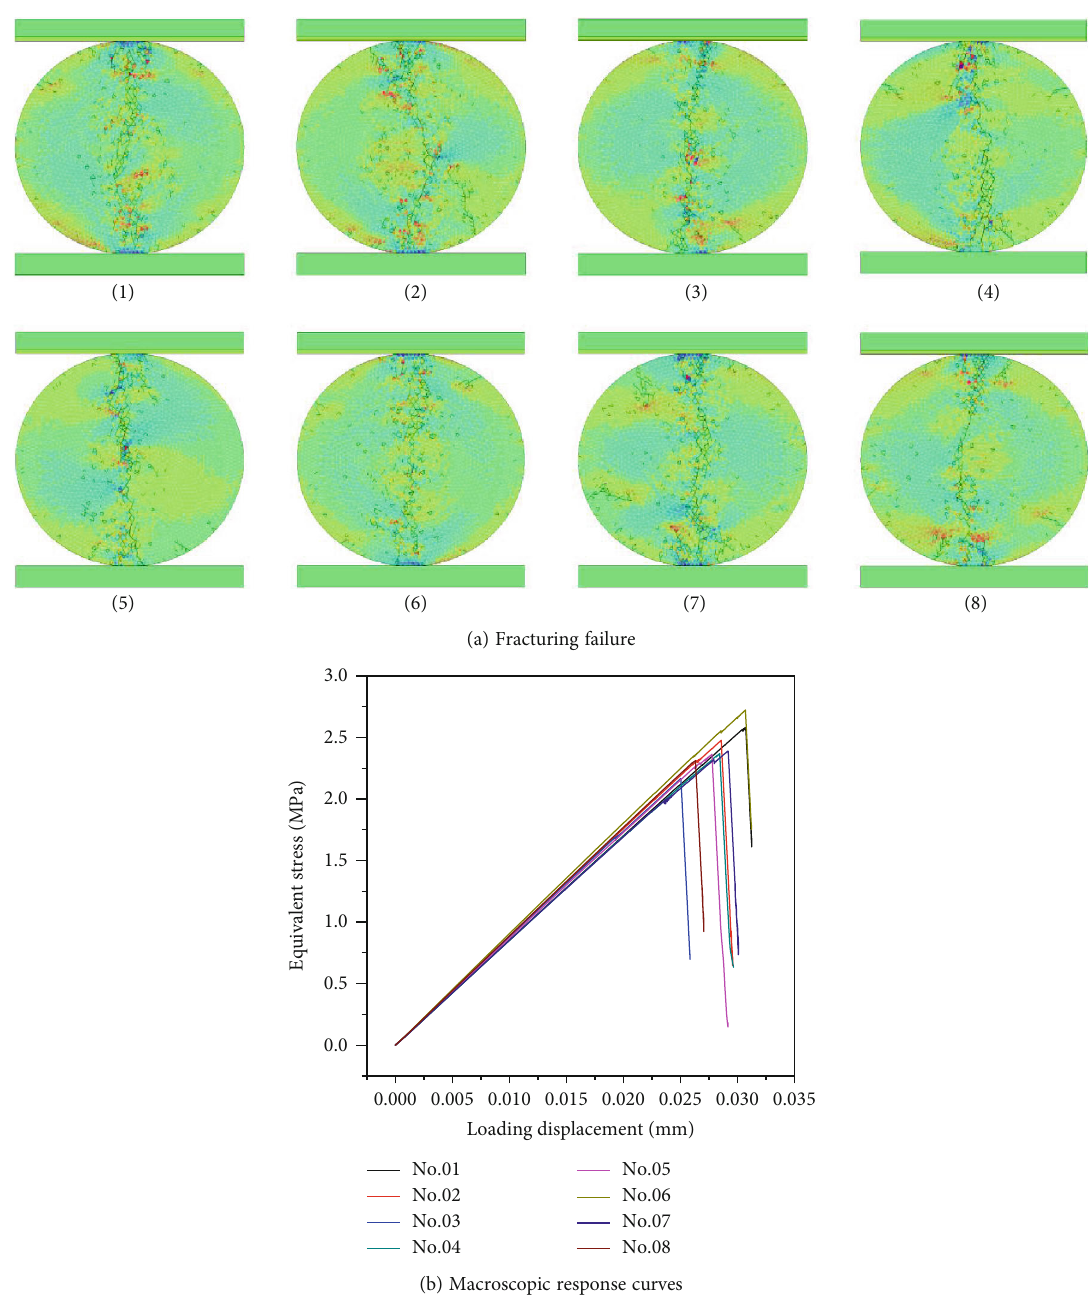
Figure 5: Simulation results of the disc when m = 2 : 5